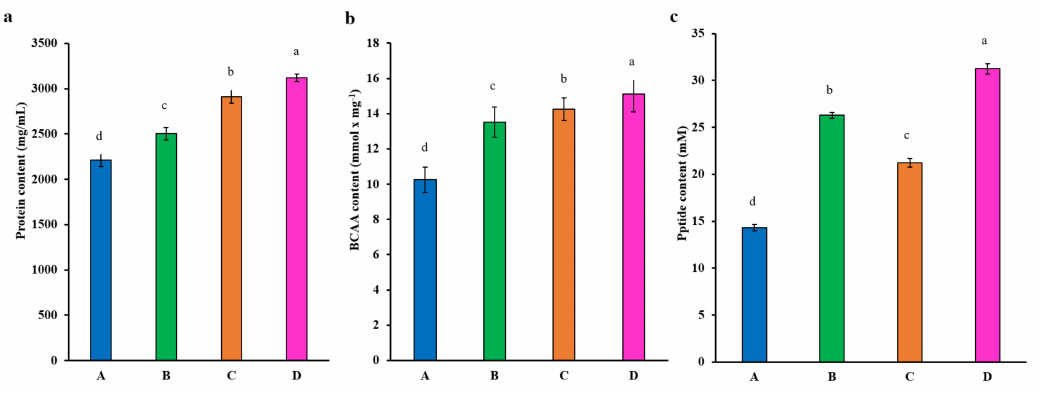
Figure 3. ( a ) Protein, ( b ) BCAA, and ( c ) peptide contents of rice protein. Lowercase letters in the same column indicate significant differences according to Duncan’s mul-tiple range tests ( p <